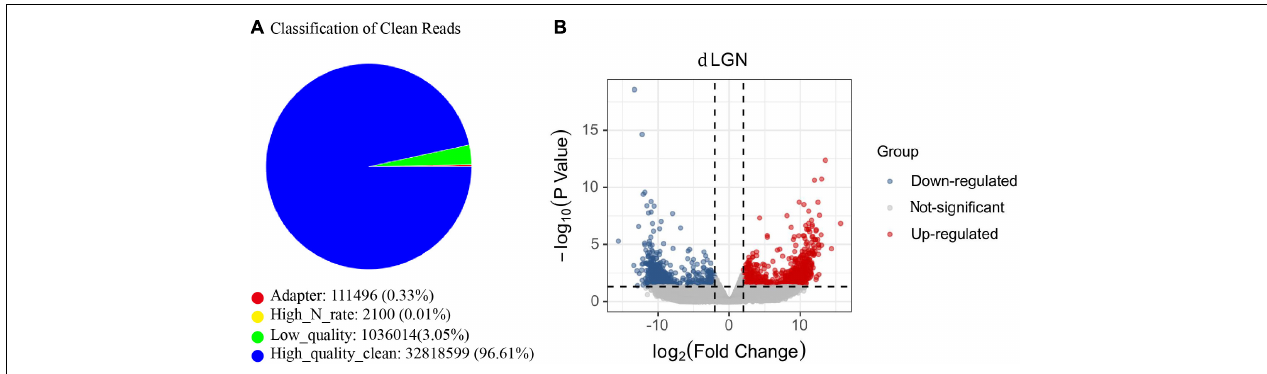
FIGURE 1 | The mRNA sequencing of the dLGN of a primate model of monocular deprivation amblyopia. (A) Quality control of mRNA sequence. The proportion of all types of reads in the sample test. “Adaptor” indicates the proportion of the number of reads containing junction sequences to the total number of reads; “High_N_rate” indicates the proportion of the number of reads containing unknown bases to the total number of reads; “Low_quality” indicates the proportion of the number of low-quality reads to the total number of reads. “High_quality_clean” is the proportion of the original sequence data to the total number of reads after removing impurities. (B) The volcano plot of the fold change and statistical significance. Gray points in the plot represent mRNA with no significant differences. Red points represent upregulated mRNAs, and blue points represent downregulated mRNAs with statistical significance.